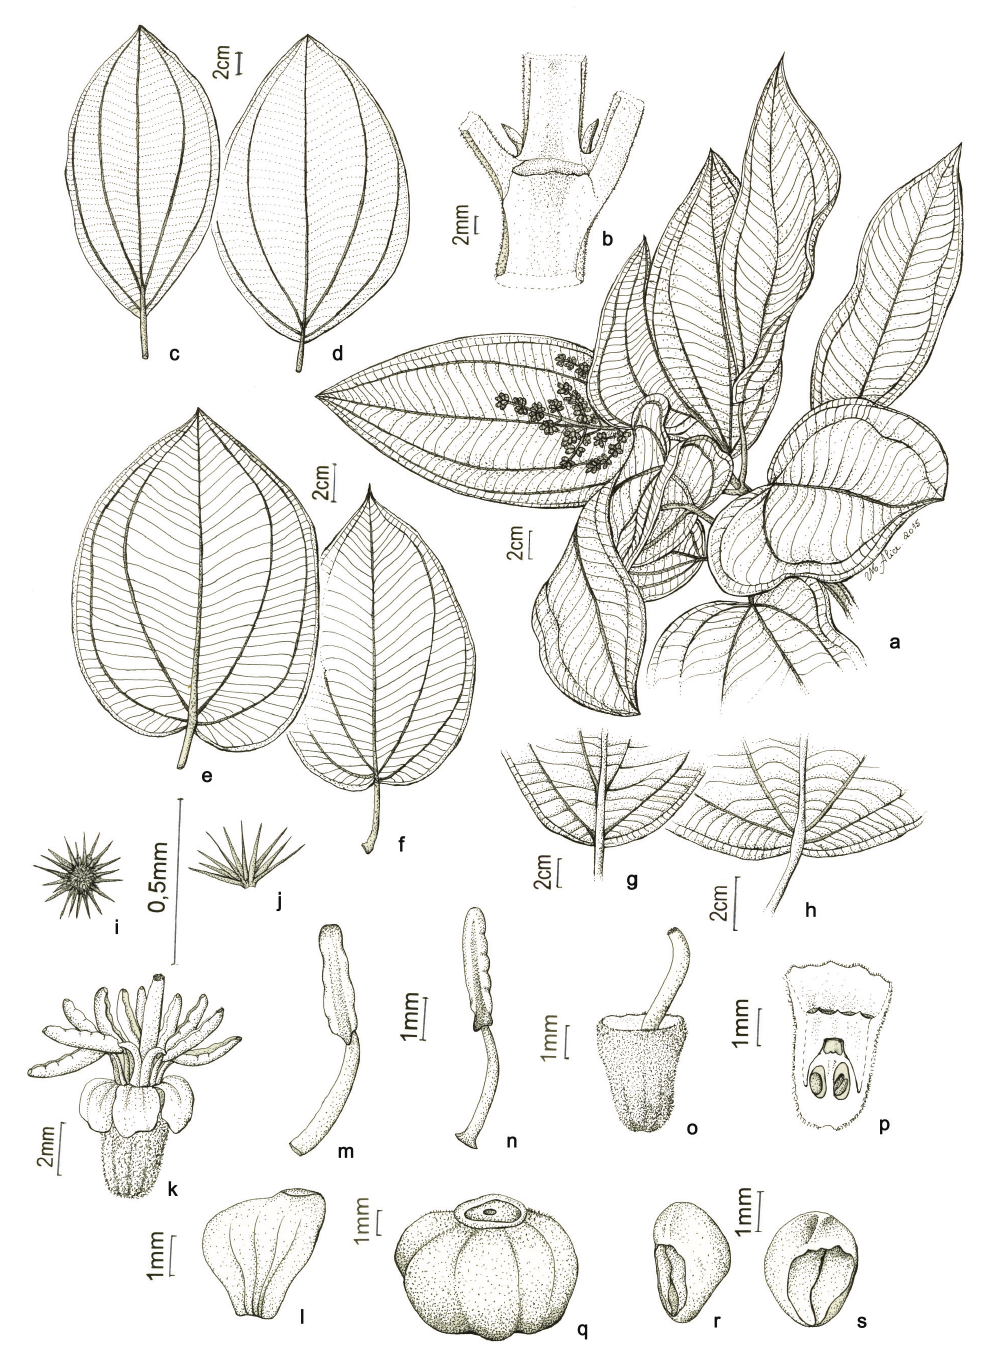
Figure 1 - Miconia gigantea Cogn. a. floriferous branch. b. branch node highlighting the interpetiolar linear bulge. c-f. morphological variation of the leaves. g-h. variation in the position of the acrodromous veins on the abaxial surface of the leaf base. i-j. trichomes of the indumentum: stellate-lepidote (I) and furfuraceous- stellate (J). k. flower. l. petal. m-n. antepetalous and antesepalous stamens, respectively. o. hypanthium and style. p. longitudinal section of the hypanthium, calyx and ovary. q. mature fruit. r-s. seeds (a-d, i-s. Baumgratz 1306 , e-h. Baumgratz s.n . (RB